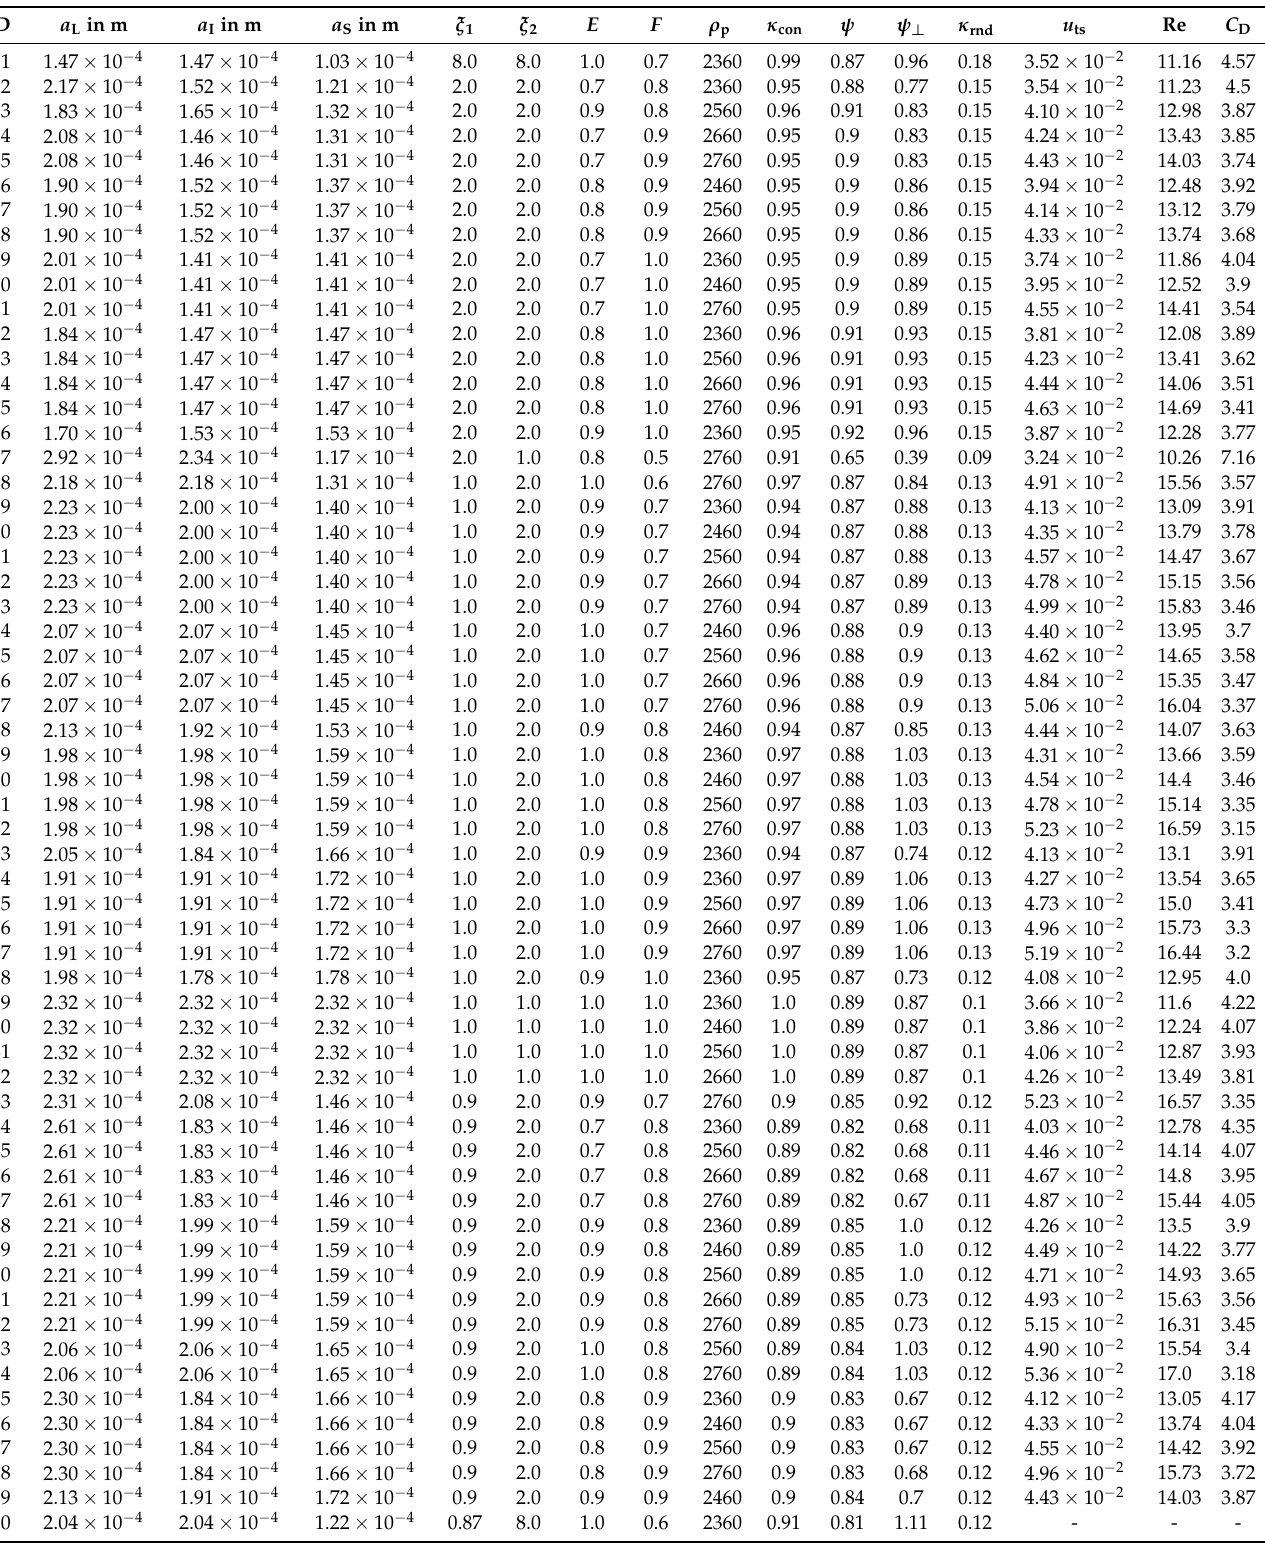
Table A1. Data of the particles in the training